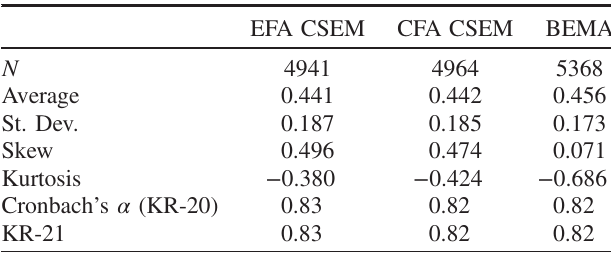
TABLE I. Test statistics for the EFA and CFA CSEM datasets and for the full BEMA